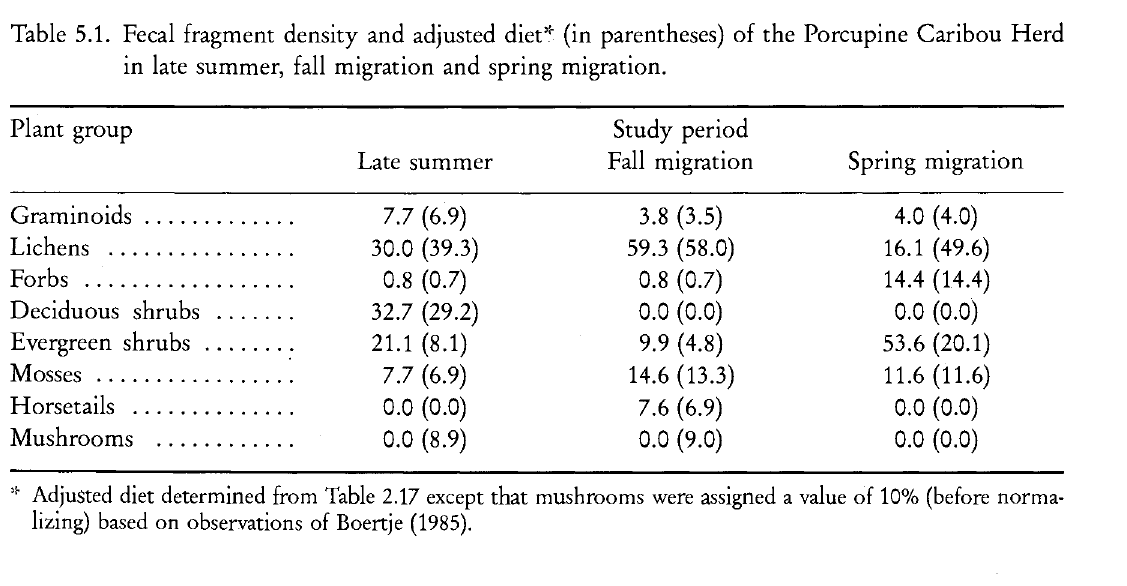
Table 5.1. Fecal fragment density and adjusted diet* (in parentheses) of the Porcupine Caribou Herd in late summer, fall migration and spring migration.